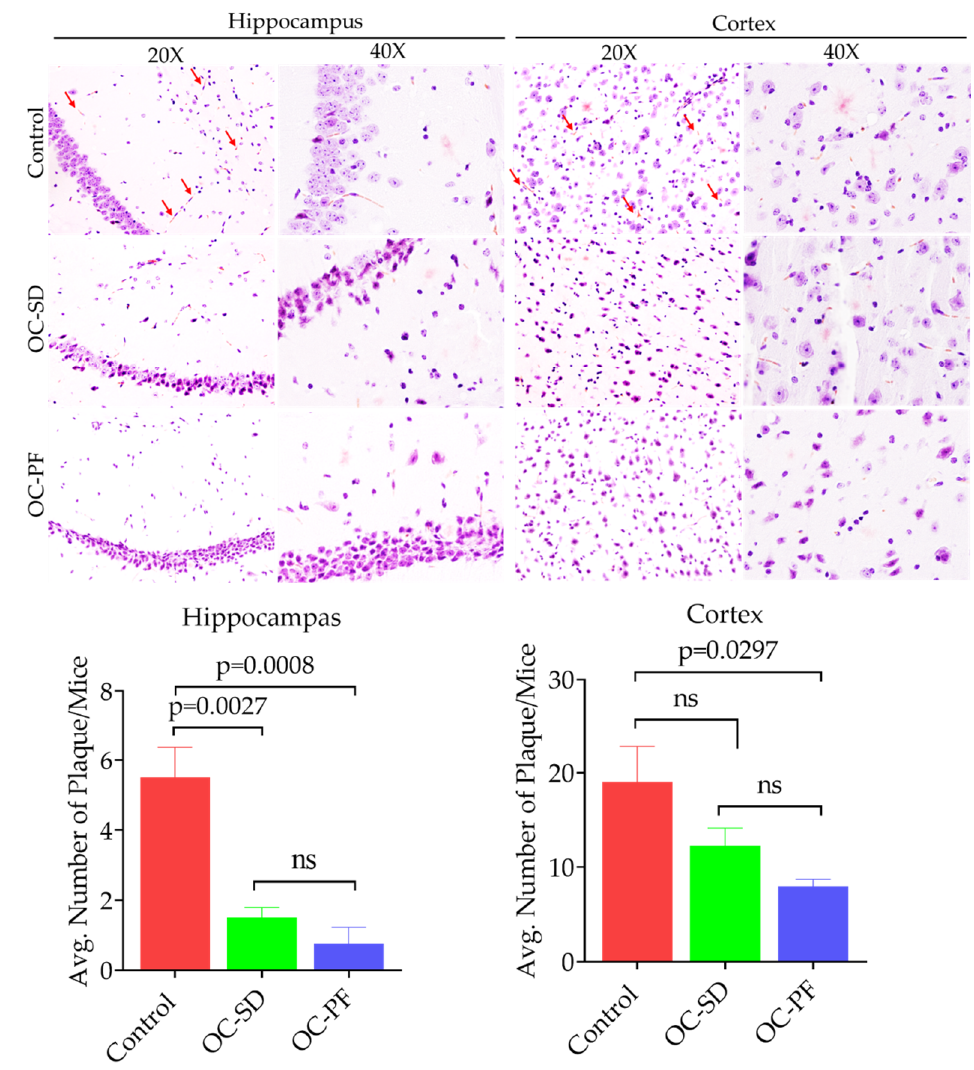
Figure 4. ( A ) OC-SD and OC-PF treatments attenuated the A β plaque deposition evidenced by Congo red staining of 5xFAD mouse brain sections ( n = 4 mice/group). Representative brain sections for A β plaque deposition in hippocampus and cortex. ( B ) Quantitative analysis of average A β plaque count in tested mice brain hippocampus sections, F (2, 9) = 18.41, p < 0.05 and ( C ) in tested mice brain cortex sections, F (2, 9) = 4.973, ns and p < 0.05. Data were analyzed using one-way ANOVA followed by post-hoc Tukey test and presented as a mean ± SEM ( n = 4 per group). “ns”: